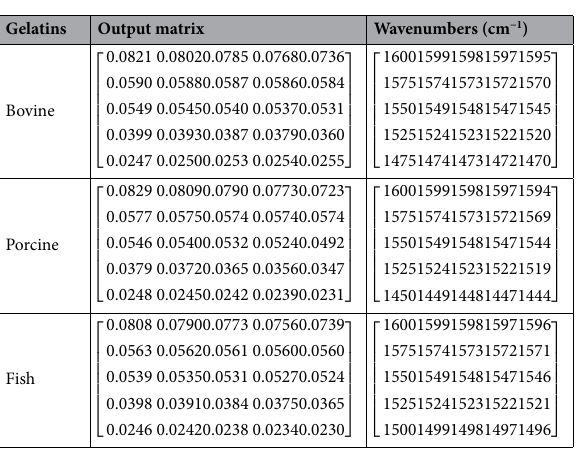
Gelatins Output matrix Wavenumbers (cm −1